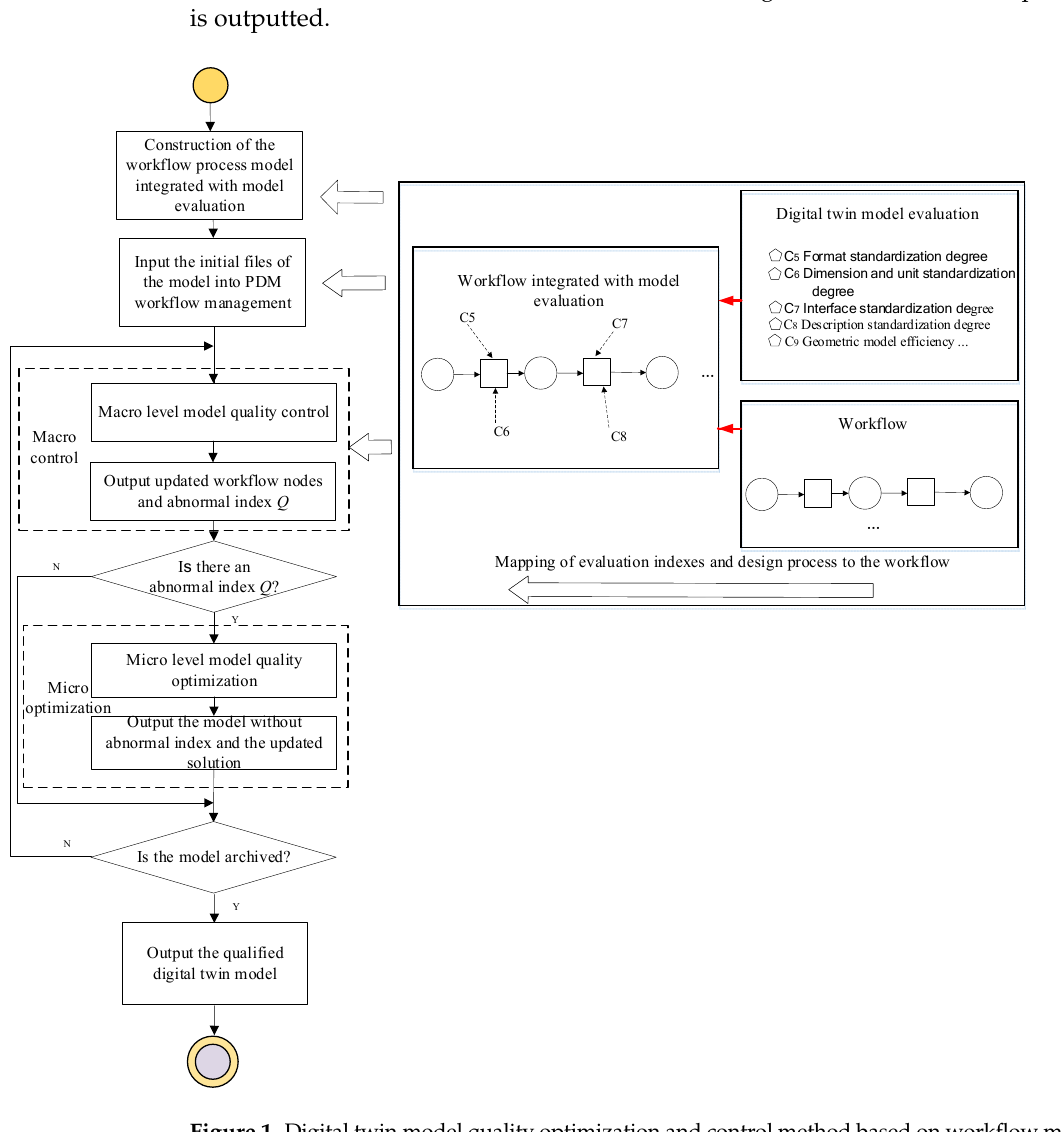
Figure 1. Digital twin model quality optimization and control method based on workflow manage- ment.